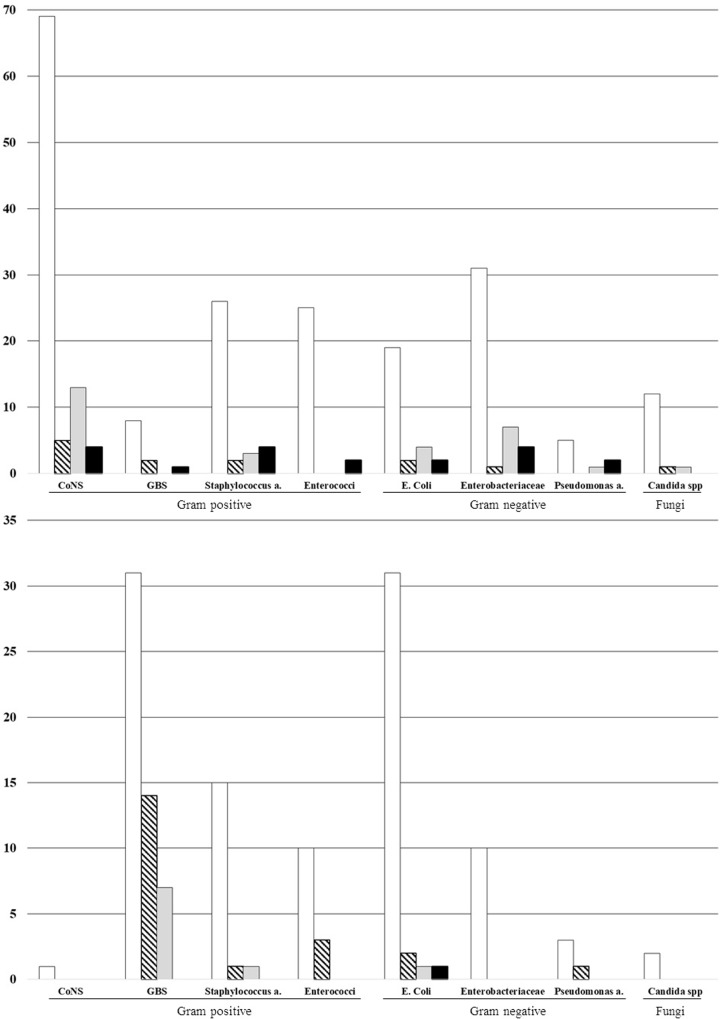
Number of total cases, meningitis, brain lesions and case fatalities according to each pathogen in hospital- (panel A) and community-acquired LOS (panel B). CoNS, coagulase-negative staphylococci; GBS, group B streptococcus. Empty bars, total cases of late-onset sepsis. Oblique striped bars, cases of meningitis. Grey bars, cases with brain lesions. Black bars, case fatalities.